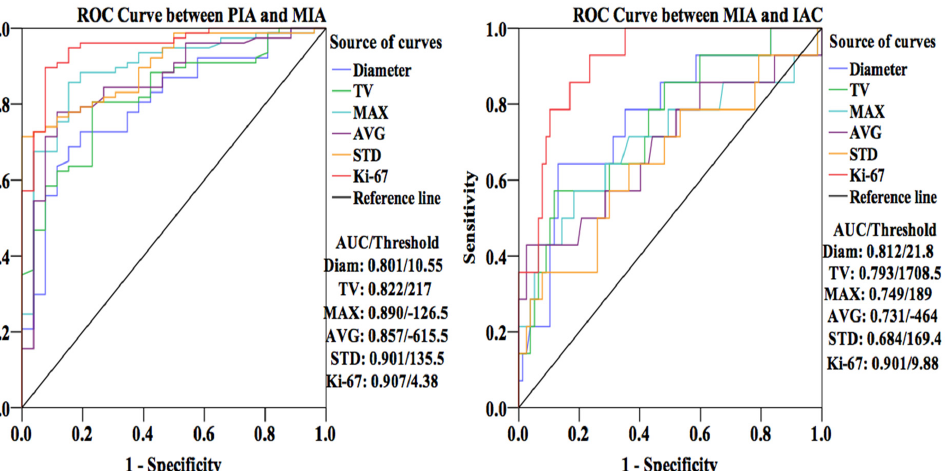
Fig 5. Receiver operating characteristic (ROC) curves of diameter, total volume (TV), the maximum CT value (MAX), average CT value (AVG), standard deviation of CT value within the whole nodule (STD) and Ki-67 labeling index (LI) for differentiation among PIA, MIA and IAC. According to area under the curve (AUC) of all variables, Ki-67 LI had a better differential capability than other parameters. It is easier to differential diagnose between PIA and MIA than between MIA and